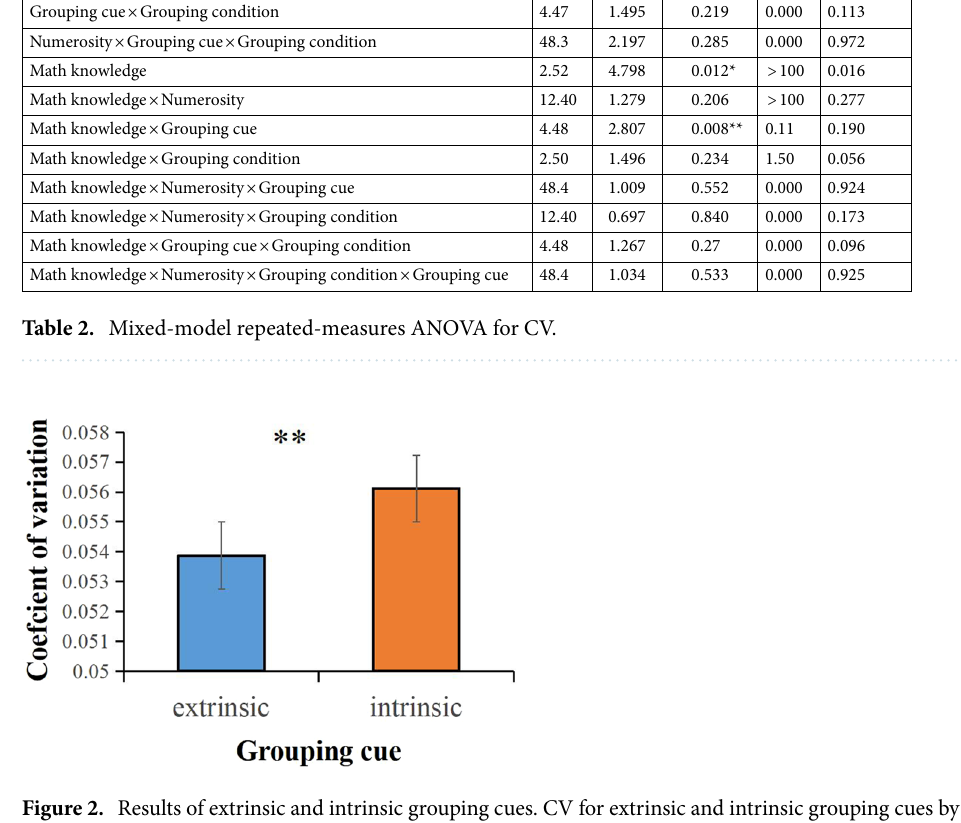
Figure 2. Results of extrinsic and intrinsic grouping cues. CV for extrinsic and intrinsic grouping cues by group condition. *** p < 0.001; ** p < 0.01; * p < 0.05.